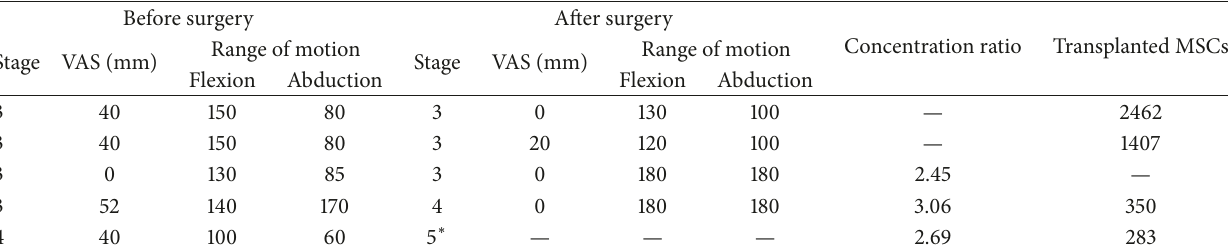
Table 2: Clinical results and blood